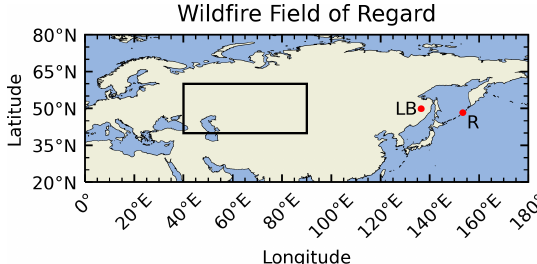
Figure 16. Field of regard for sampling air that has not been im- pacted by the Raikoke event but may have been impacted by coinci- dent Northern Hemisphere wildfires. LB and R indicate the location of the Lake Bolon (Siberia) fire and Raikoke,